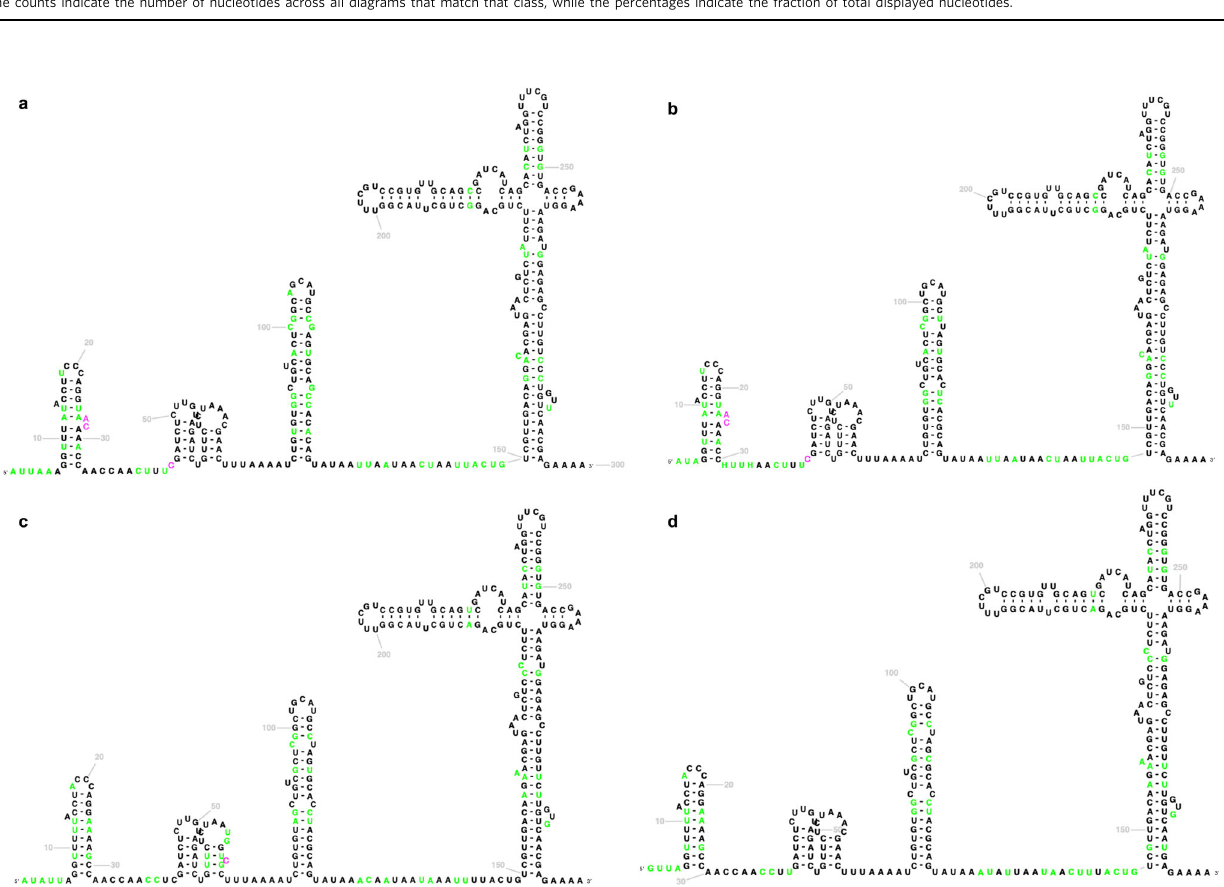
Fig. 5 Coronavirus 5 ′ UTR 2D structures displayed using the Sarbecovirus Rfam family (RF03120). a , b SARS-CoV-2 isolates (MT019530.1 and MT263421). c SARS Coronavirus Urbani isolate (MK062184.1); d Bat SARS Coronavirus HKU3-1 (DQ022305.2). The standardised 2D layouts facilitate structure comparison, with colour coding highlighting the differences between individual sequences and the model. Nucleotides in black are identical to the Rfam consensus sequence and the template, nucleotides shown in green are different between the input sequence and the template, while magenta nucleotides represent